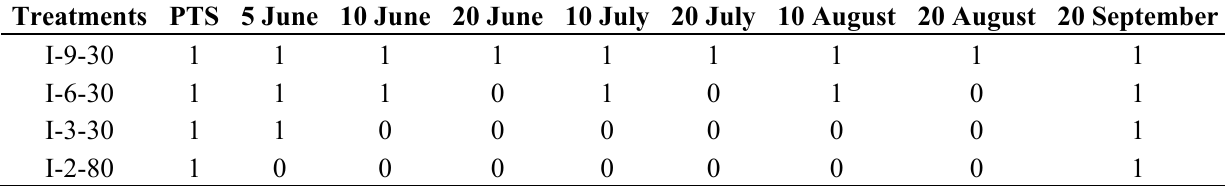
Table 2. Paddy field discharge schedule. PTS is pre-transplantation